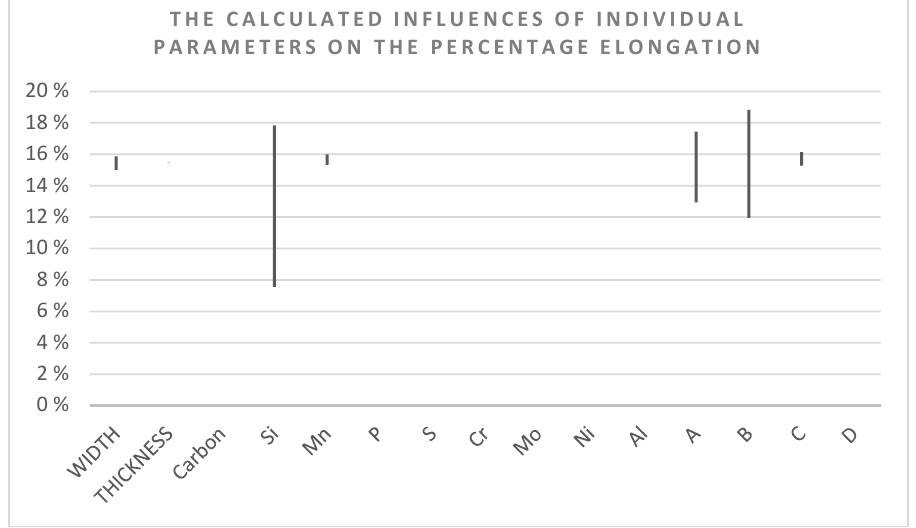
Figure 9. The calculated influences of individual parameters on the percentage elongation while separately changing individual parameter within the individual parameter range.